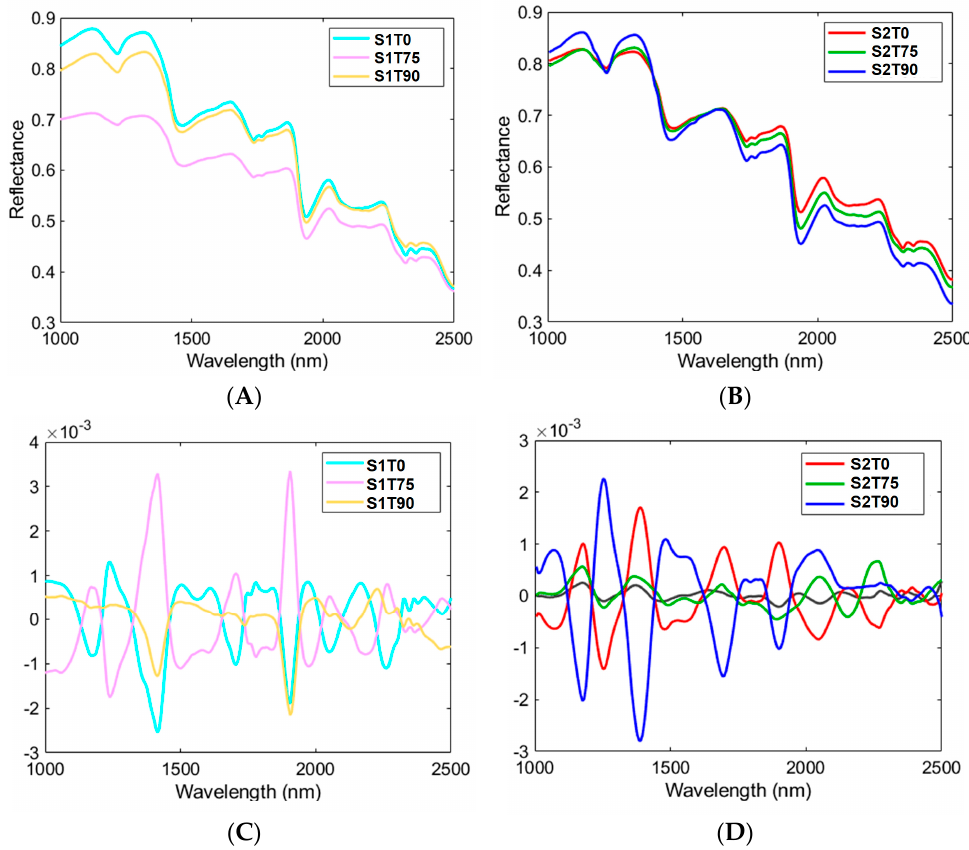
Figure 6. Average ( A , B ) raw and preprocessed ( C , D ) spectra of samples analysed by hyperspectral imaging (HSI) in the SWIR range.